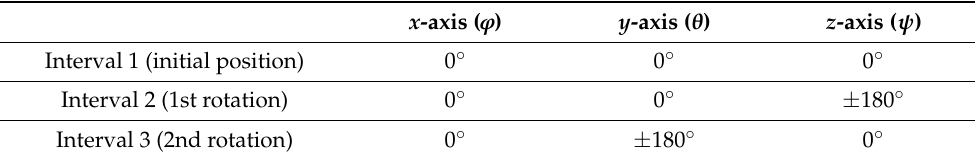
Figure 3. 3D demonstration of IMU rotation sequences in three steps. Table 1. IMU rotation